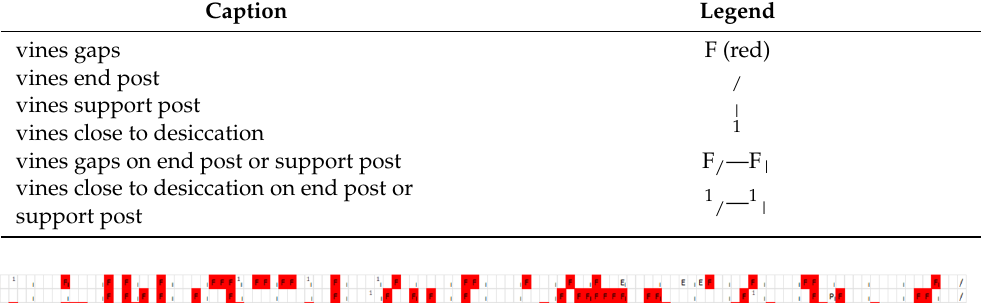
Table 1. Experimental vineyard mapping.